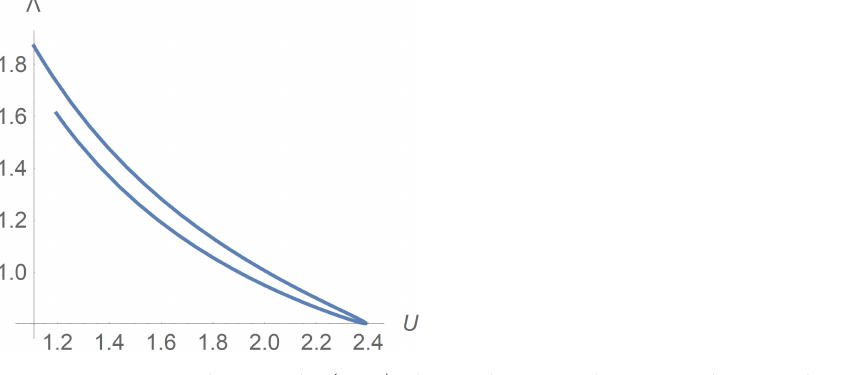
Figure 7. Hysteresis loop on the ( U , Λ ) plane, where U is the mean velocity and Λ is the friction factor. The data are the same as in Figure 2.